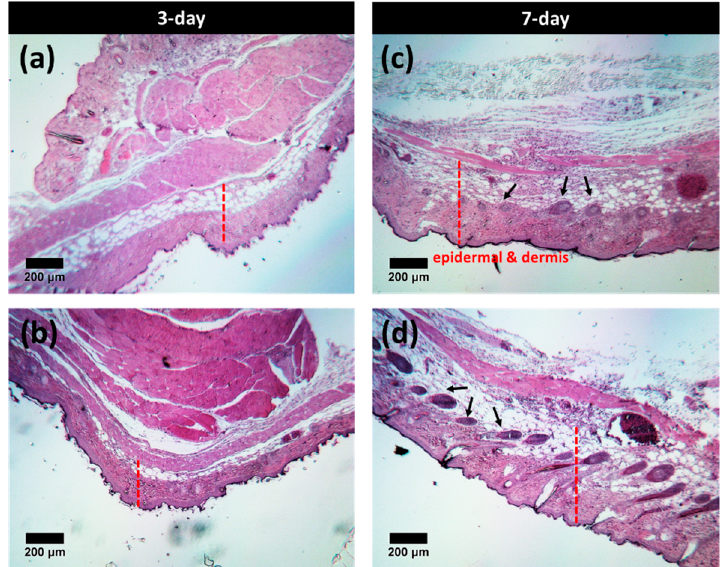
Figure 8. Photomicrographs of histological comparison between PF127/SA IPN hydrogels ( a , c ) without VEGF and ( b , d ) with VEGF for mouse wound healing. Each sample was taken after 3 d and 7 d intervals and stained with H&E (new tissue generation marked with an arrow; the red dashed line indicates thickness of the tissue). H&E, hematoxylin and eosin stain